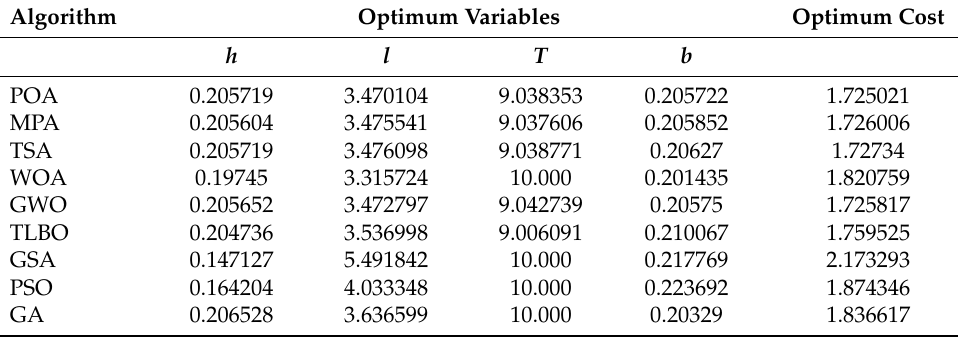
Table 13. Comparison results for welded beam design